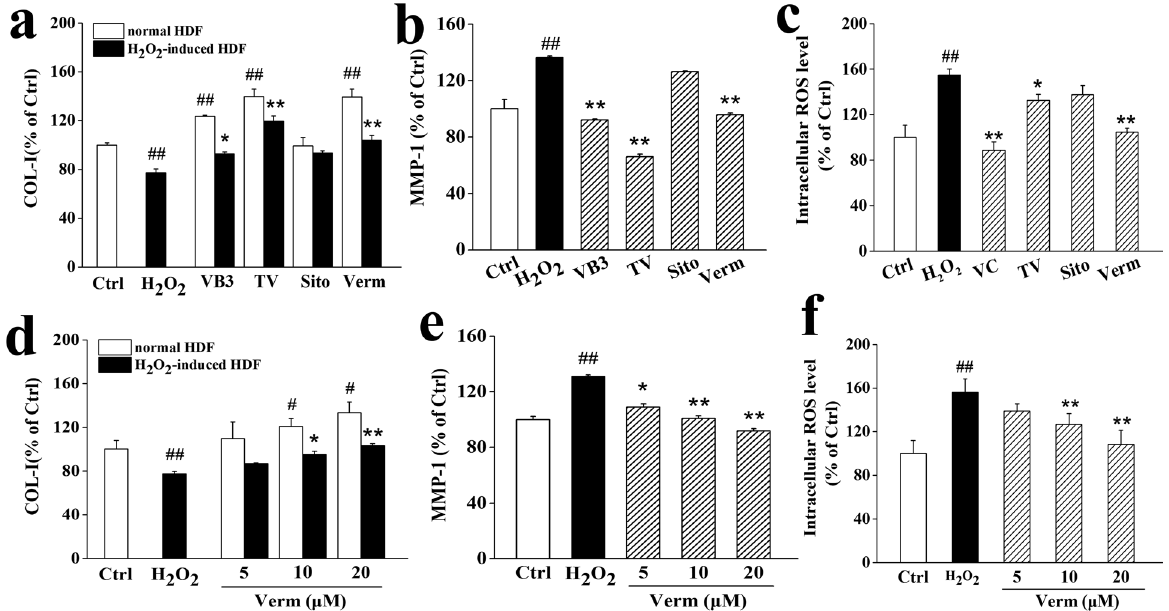
O -induced HDF. COl-I secretion ( a, 2 2 O 2 2